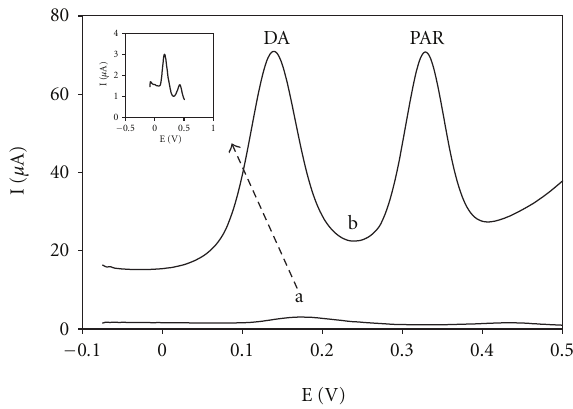
Figure 3: Di ff erential pulse voltammograms of 70 μ M DA and 50 μ M PAR at (a) GC and (b) MWCNTs/GCE in 0.1M phosphate bu ff er solution (pH 7). Other conditions: open circuit, t acc = 60 s, pulse amplitude = 50mV, scan rate = 10 mV · s − 1 , interval time 0.5 s, modulation time = 0.2s, and step potential = 5mV.